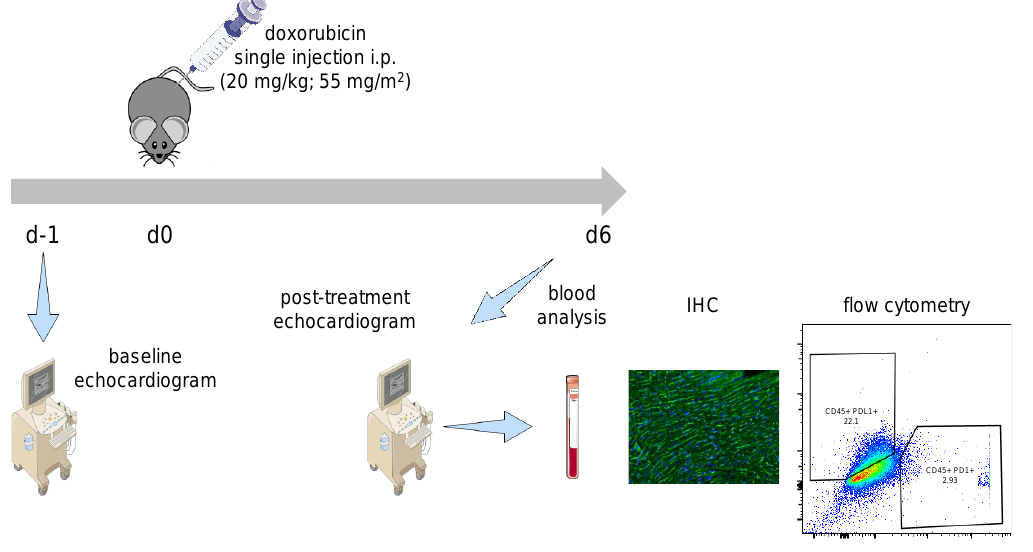
Figure 1. Treatment regime. After initial transthoracic echocardiography, mice received a single intraperitoneal (i.p.) injection of Doxorubicin (20 mg/kg; 55 mg/m 2 ). After 6 days, heart function was re-evaluated using echocardiography. Mice were sacrificed and the effects of Doxorubicin on cardiac PD1/PDL1 signaling were analyzed using flow cytometry and immunohistochemistry.